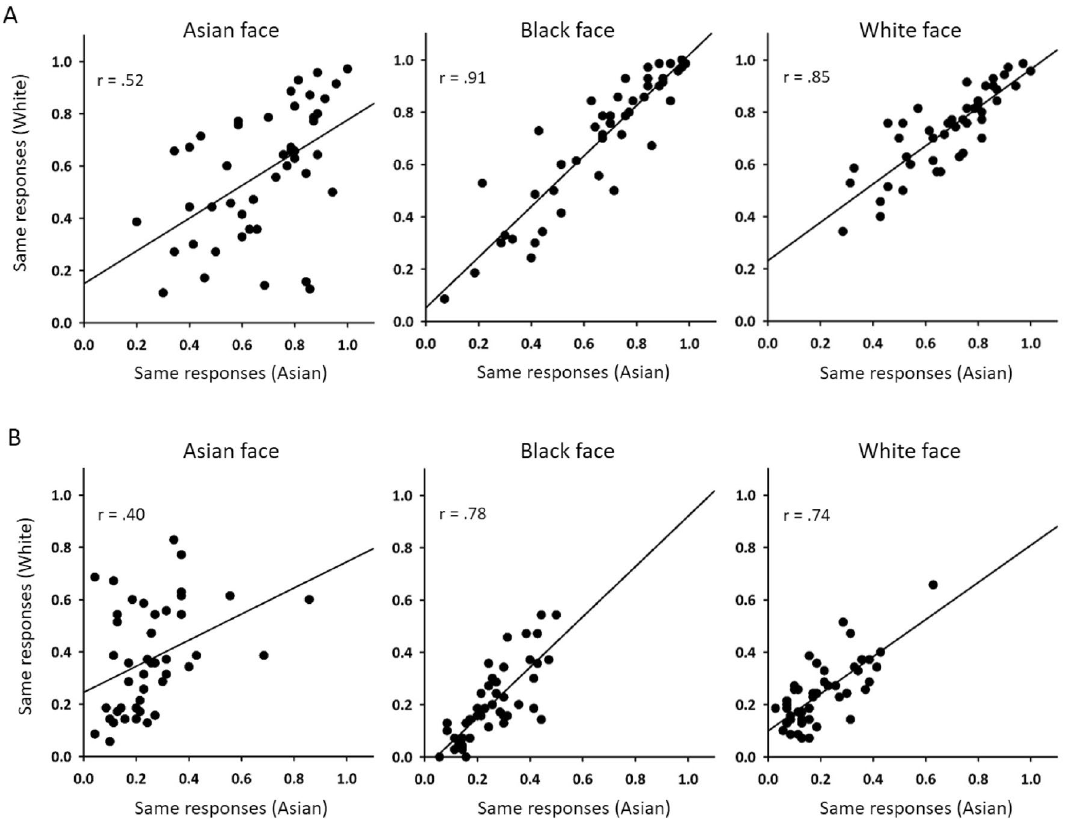
Figure 3. A comparison of an item-analysis across the two participant groups on ( A ) same identity and ( B ) different identity trials. Significant positive correlations show that Asian and White participants from different ethnicity made qualitatively similar responses on all matching